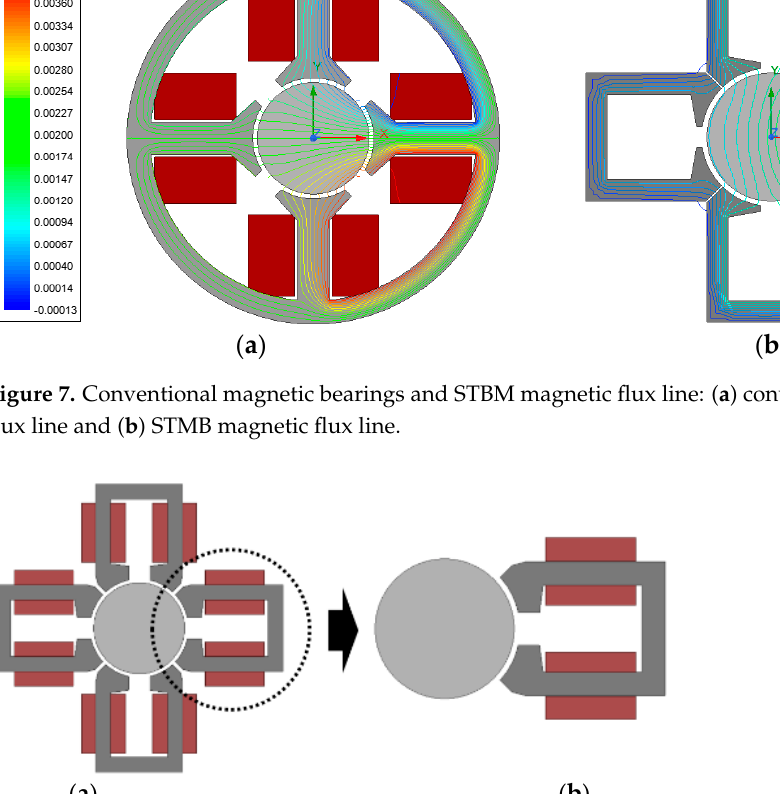
Figure 8. Full module and one-module models: ( a ) STMB full model and ( b ) STMB with one module model.